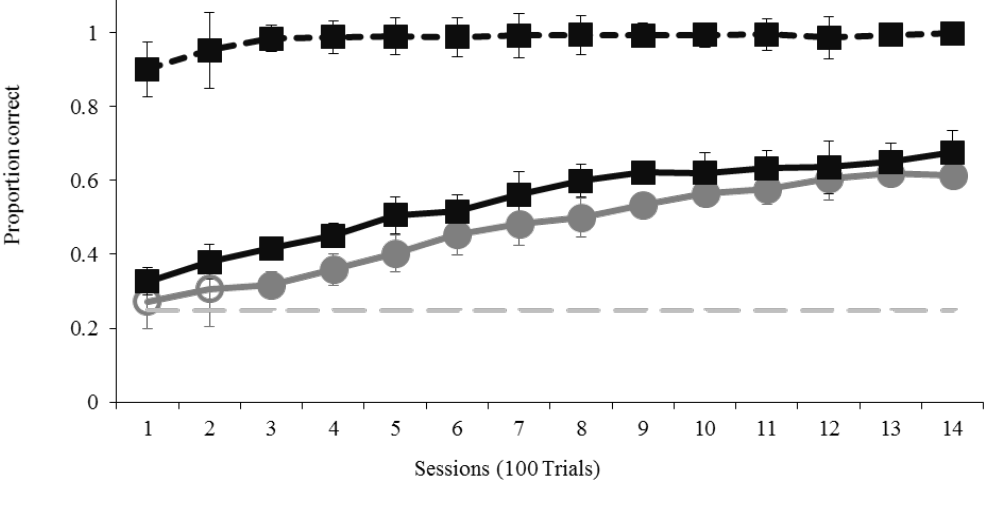
Figure 4. Average performance across the four repetitions of Experiment 2. Solid lines indicate accuracy on trial-and-error trials that do not involve exclusion for the exclusion image set (black) and basic image set (grey). The dotted black line indicates accuracy on exclusion trials. The dashed grey line indicates chance level, error bars indicate standard errors. Filled data markers indicate above chance performance, empty data markers indicate performance that does not differ from